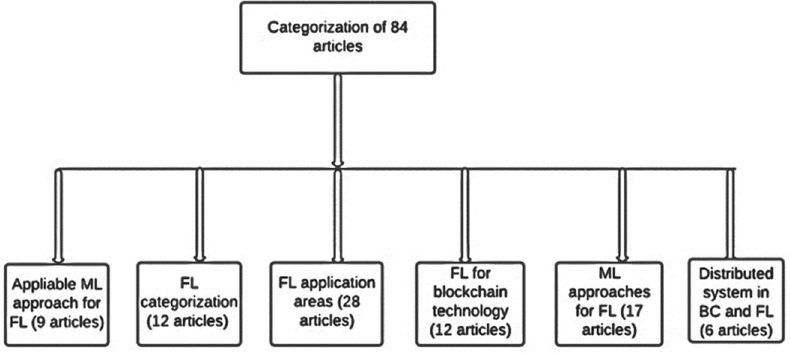
Figure 4. Articles that are pertinent to the study which was reviewed.